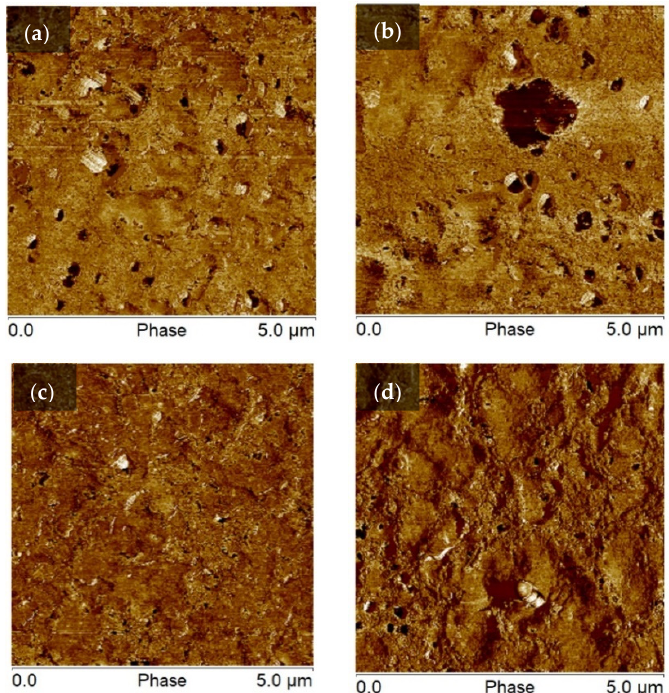
Figure 5. Phase AFM images of the grafting process with the reaction time of ( a ) 2 h; ( b ) 4 h; ( c ) 6 h; ( d ) 7 h.